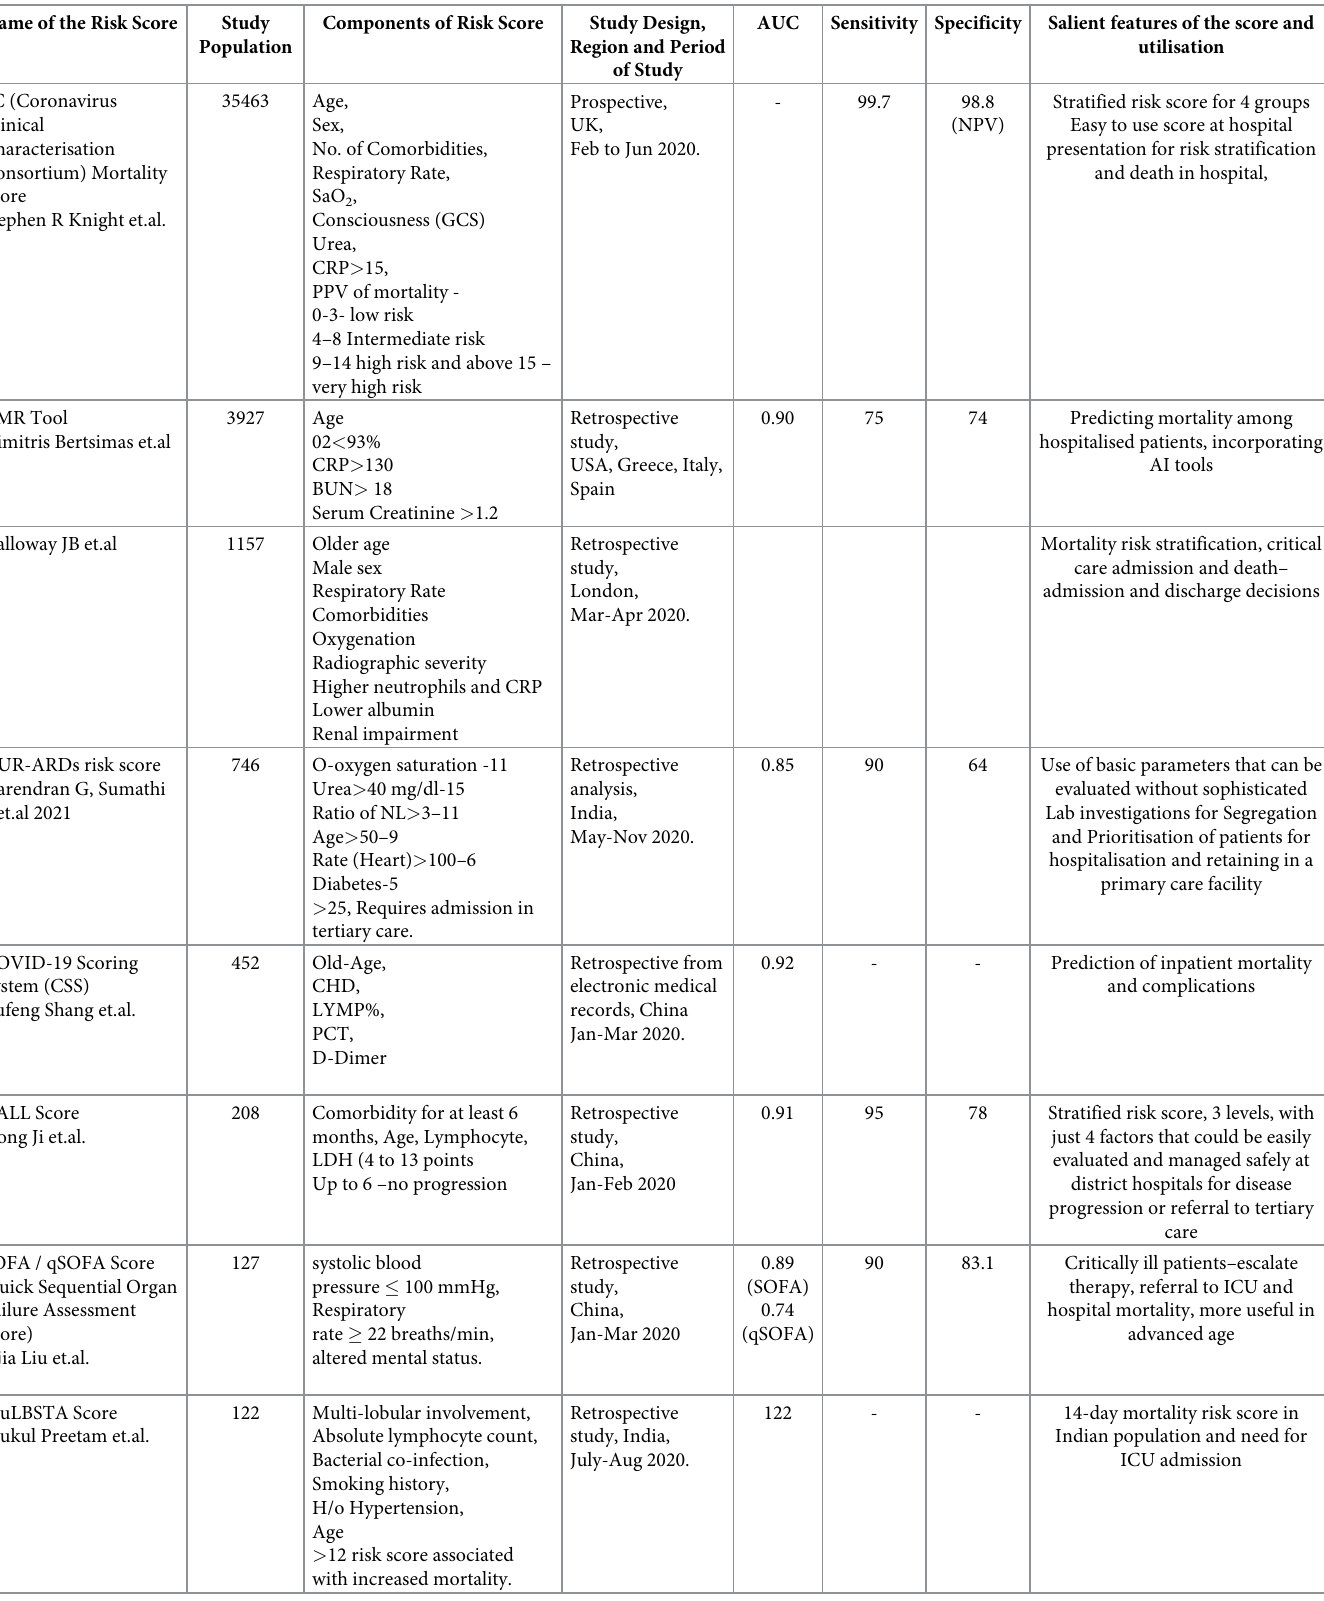
Table 3. A concise comparison of risk scores used for triaging COVID-19 patients and their potential utilisation in clinical practice and public health. Name of the Risk